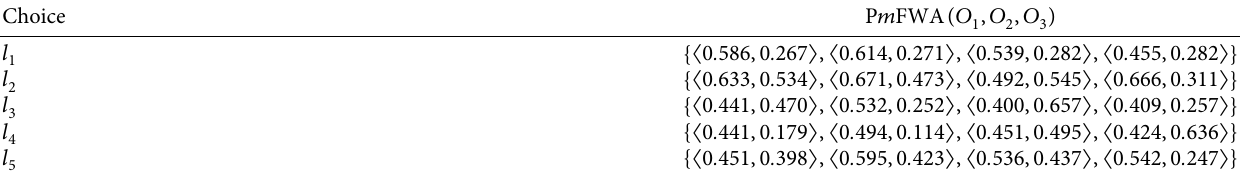
,O ,O ) for each choice. 1 2 3